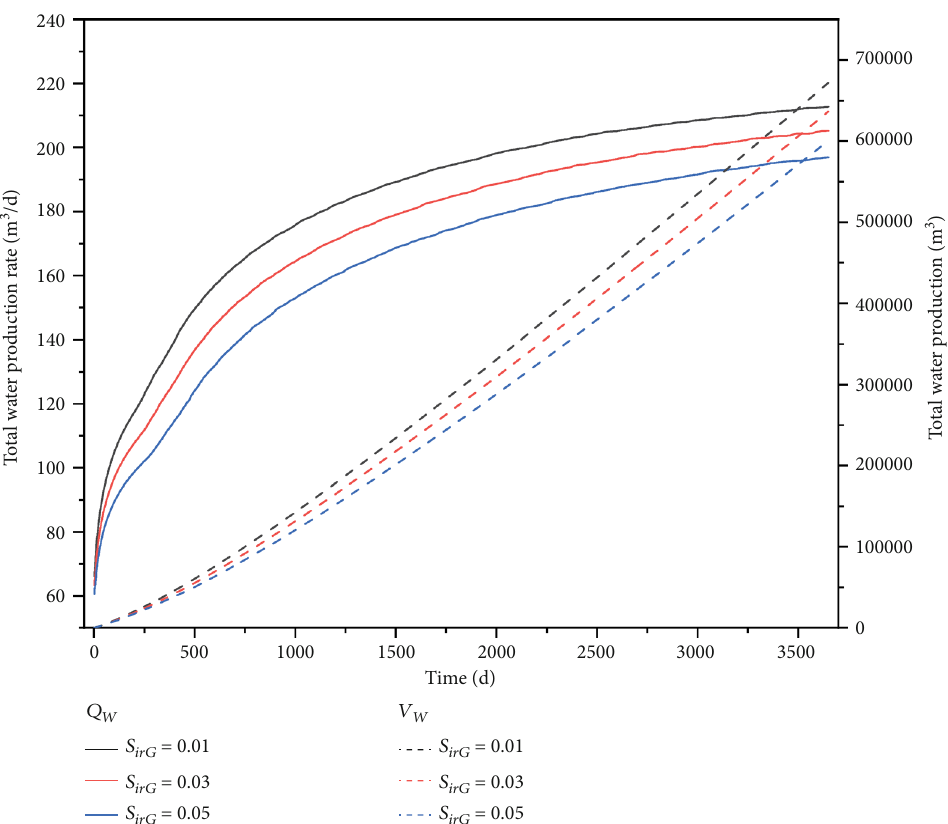
Figure 13: Evolution of total water production rate Q